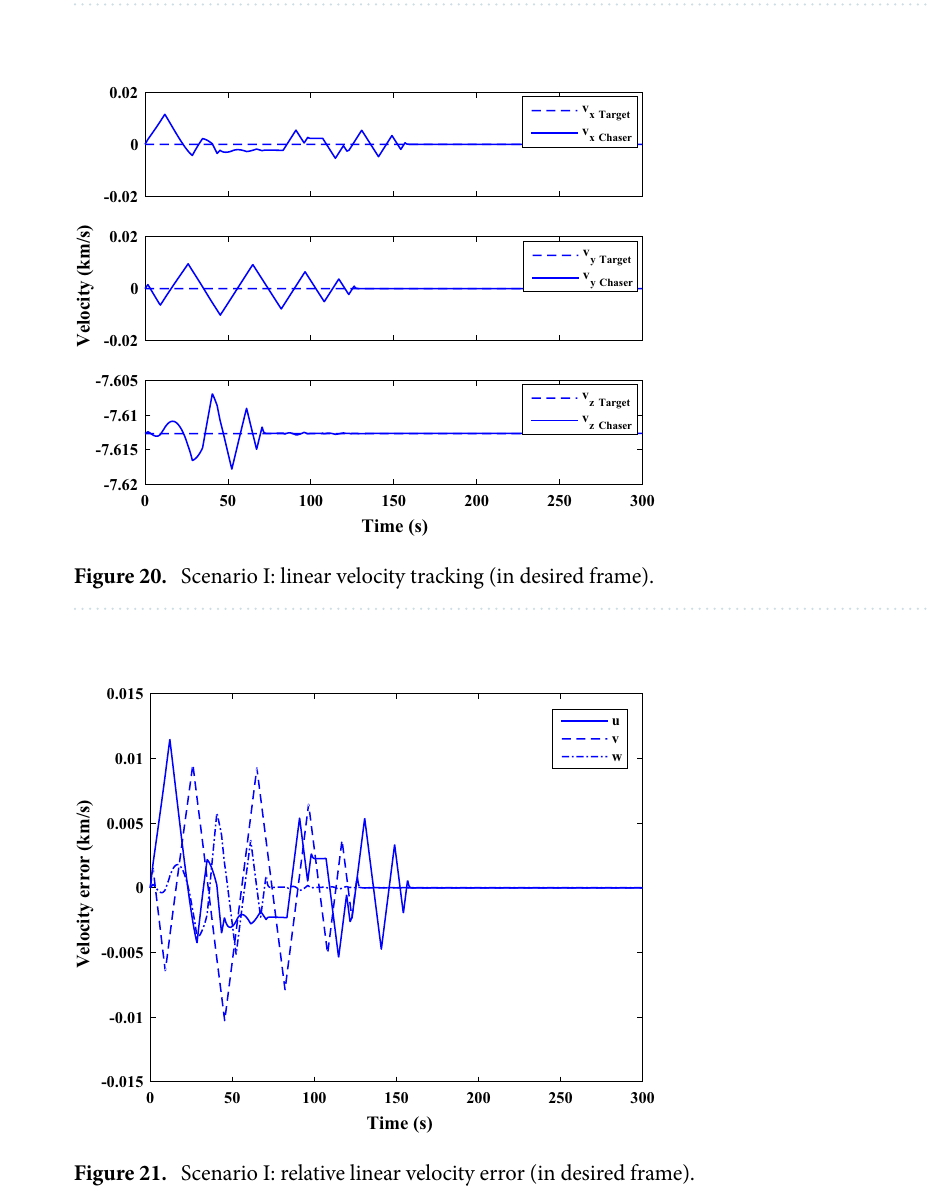
Figure 19. Scenario I: chaser’s RWs torque.